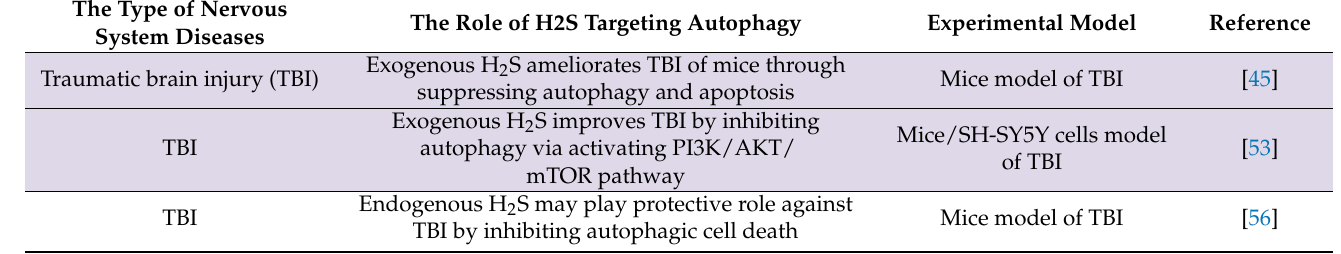
Table 1. The summary of the role of H 2 S targeting autophagy in the pathological processes of the nervous